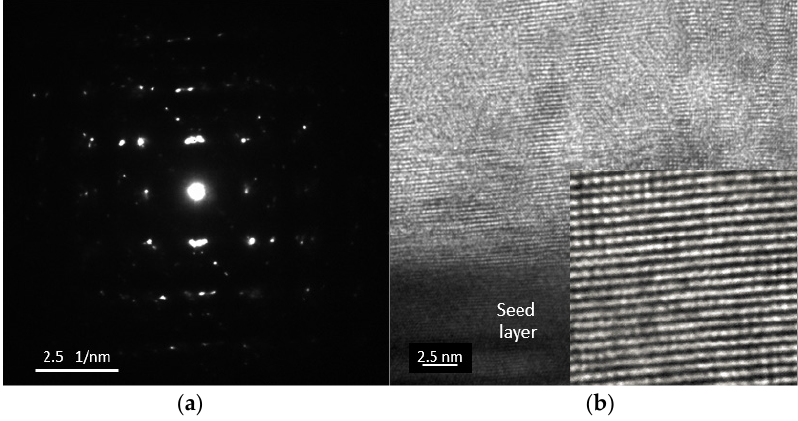
Figure 14. ( a ) SAED pattern; and ( b ) HRTEM observation between the boundaries of the Bi 2 Te 3 sample fabricated using pulsed deposition.